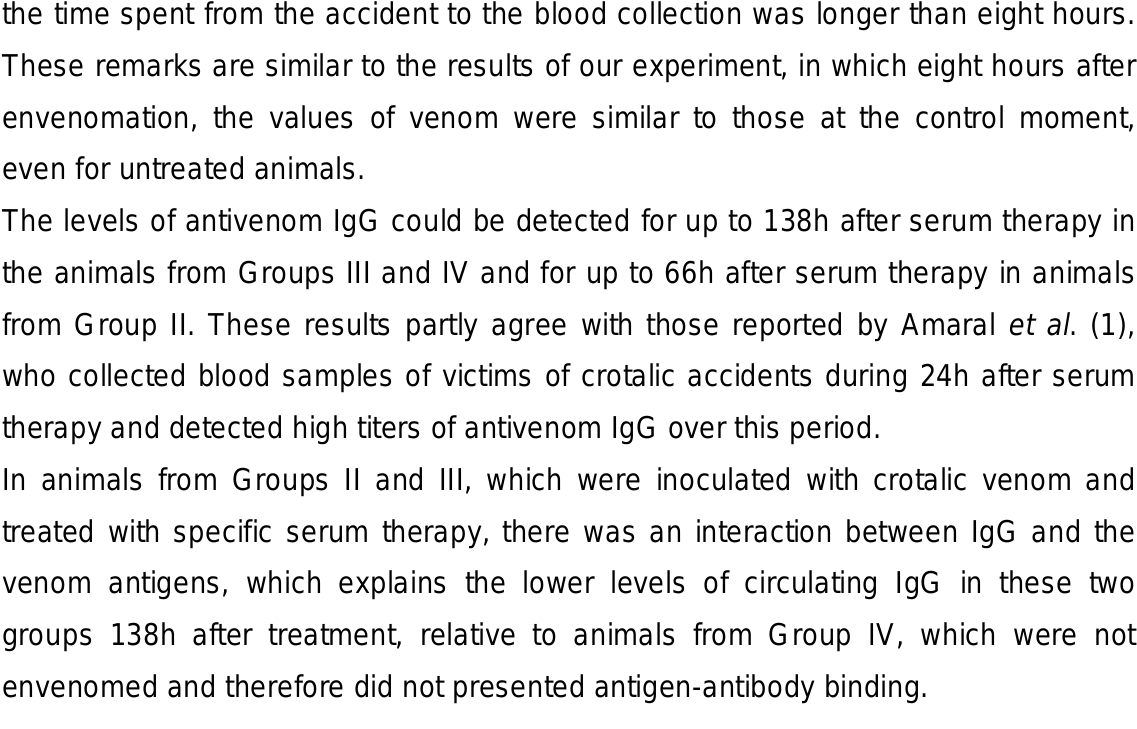
F. Sangiorgio et al. KINETICS OF VENOM AND ANTIVENOM SERUM LEVELS, CLINICAL EVALUATION AND THERAPEUTIC EFFECTIVENESS IN DOGS INOCULATED WITH Crotalus durissus terrificus VENOM.